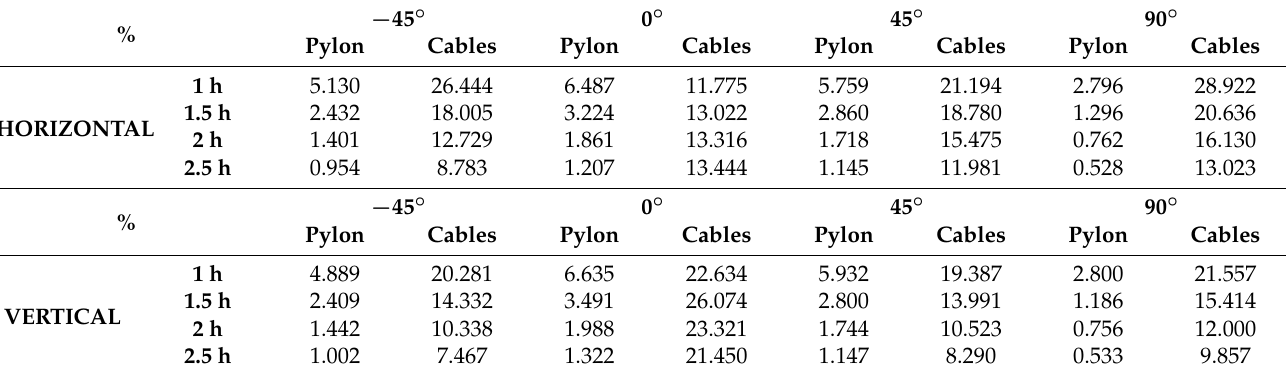
Table 5. Percentage of occupation of the pylon and the cables of the photographs in relation to the angle and the height of the pylon for the horizontal and vertical